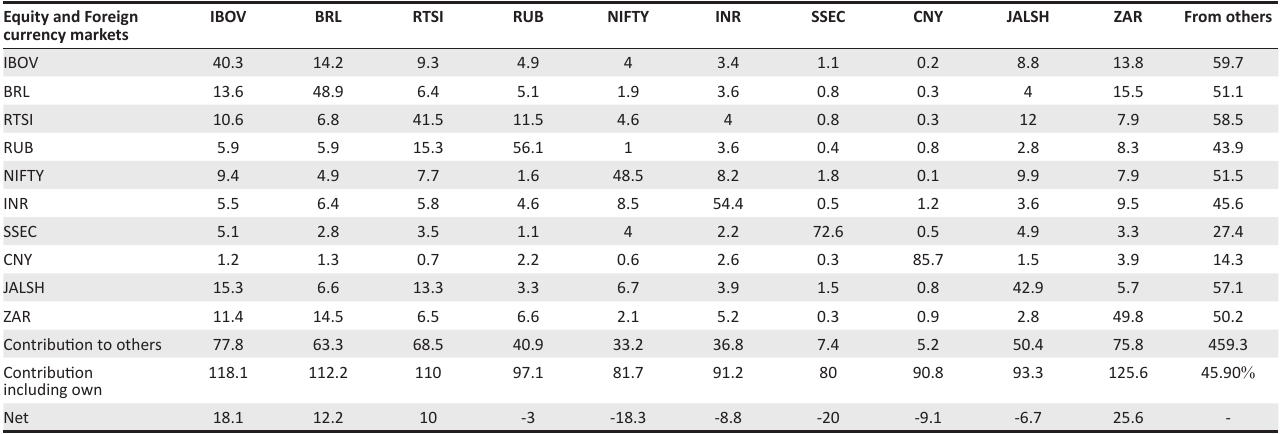
TABLE 5: The Brazil, Russia, India, China and South Africa cross-country, cross-market spillovers. Equity and Foreign currency